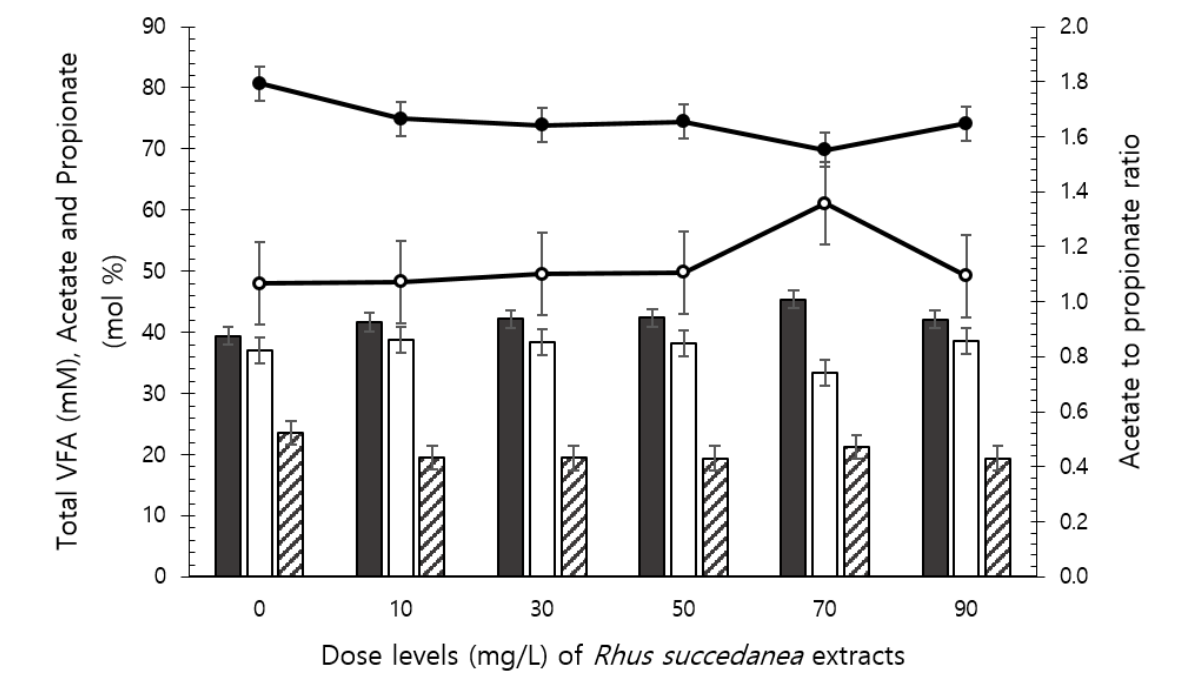
Figure 1. In vitro ruminal fermentation characteristics at 24 h incubation by different doses of Rhus succedanea extracts. Total volatile fatty acid (filled circle), acetate to propionate ratio (open circle), acetate (solid bar), propionate (open bar), and butyrate (hatched bar) concentrations. Error bars are standard error of the